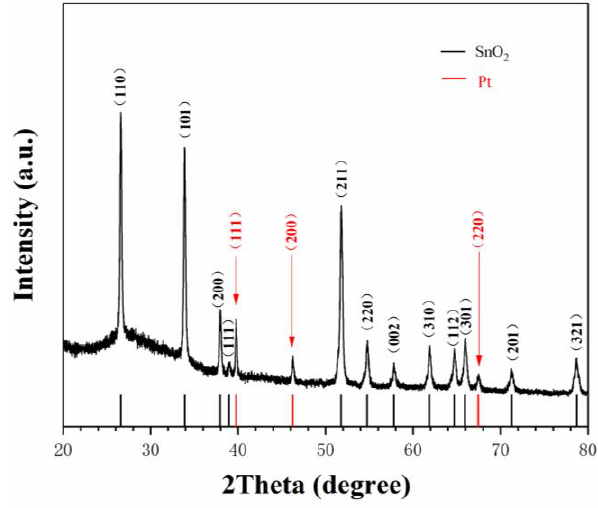
Figure 2. X-ray diffraction pattern taken on the surface of a pellet which was prepared using Pt powder (5 wt%) and SnO 2 nanoparticles and sintered at 825 °C in air.